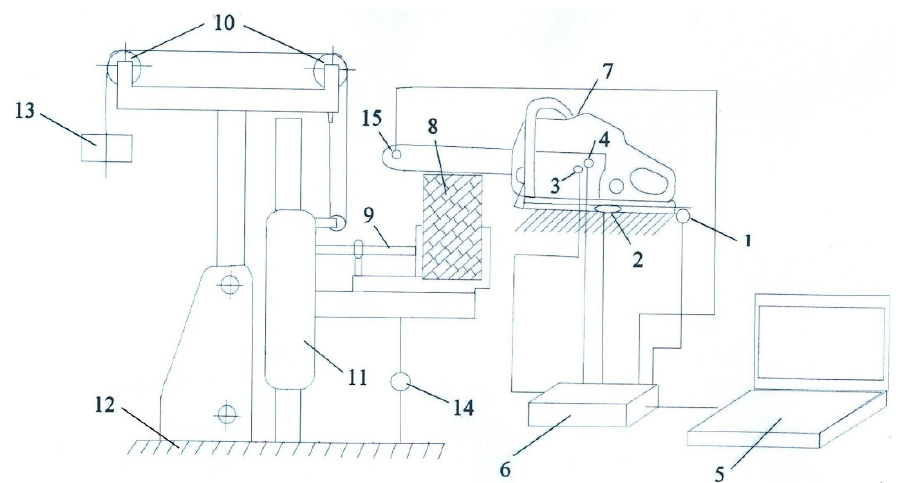
Figure 1. Scheme of experimental stand for measuring chainsaw cutting parameters (1—cutting force sensor, 2—feed force sensor, 3—sensor measuring crankshaft rotational speed, 4—sensor measuring clutch drum rotational speed, 5—computer, 6—measurement amplifier, 7—chainsaw, 8—wood sample, 9—vise, 10—guide rollers, 11—slider, 12—base, 13—weight, 14—detachable sensor measuring static feed force, 15—guide bar temperature sensor).